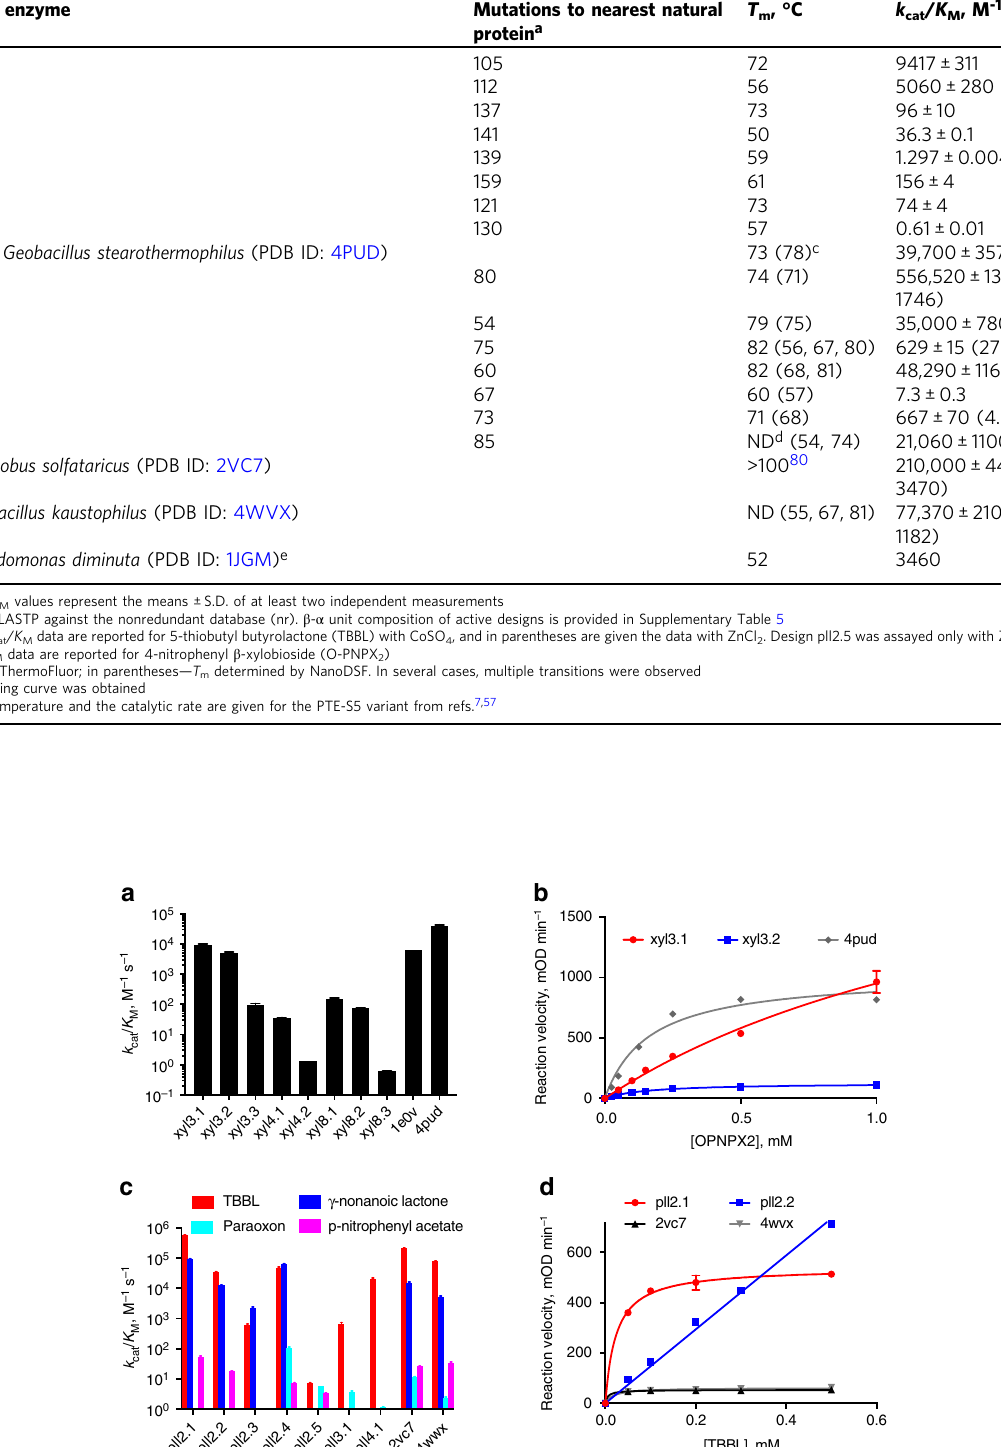
Table 1 Parameters of active GH10 and PLL designs Design/native enzyme